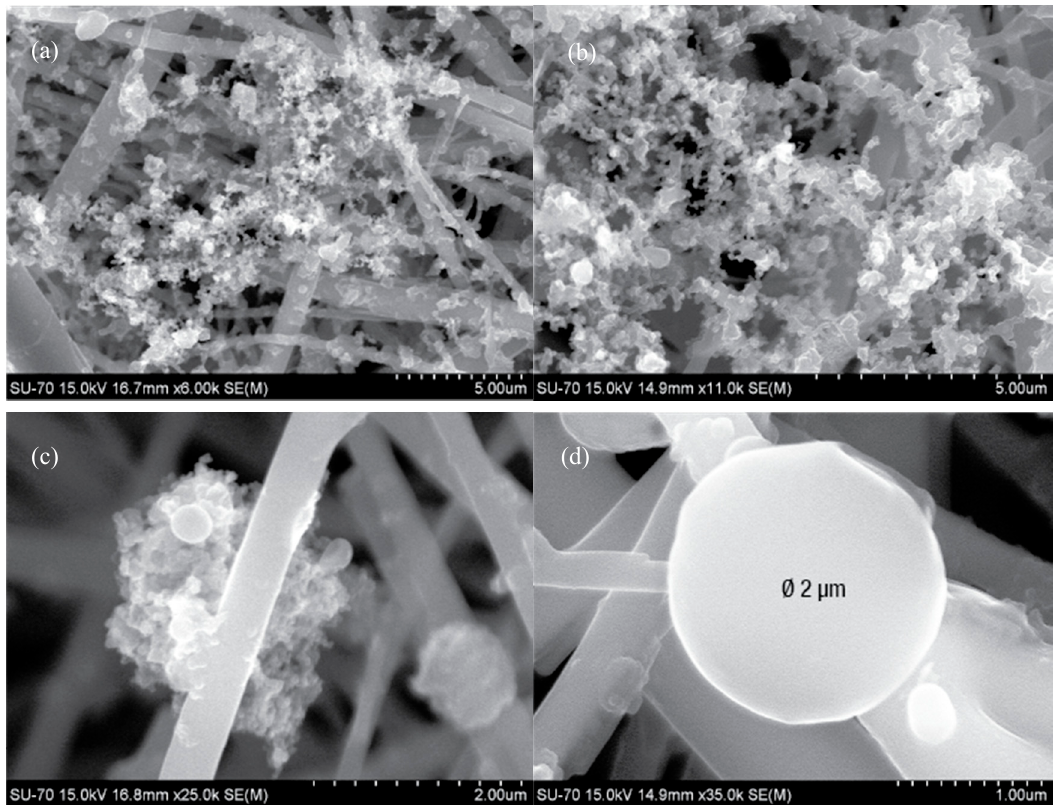
Figure 4. SEM images of soot aggregates with branching structures ( a , b ) and with cenosphere fly ash ( c , d ) in outdoor samples.